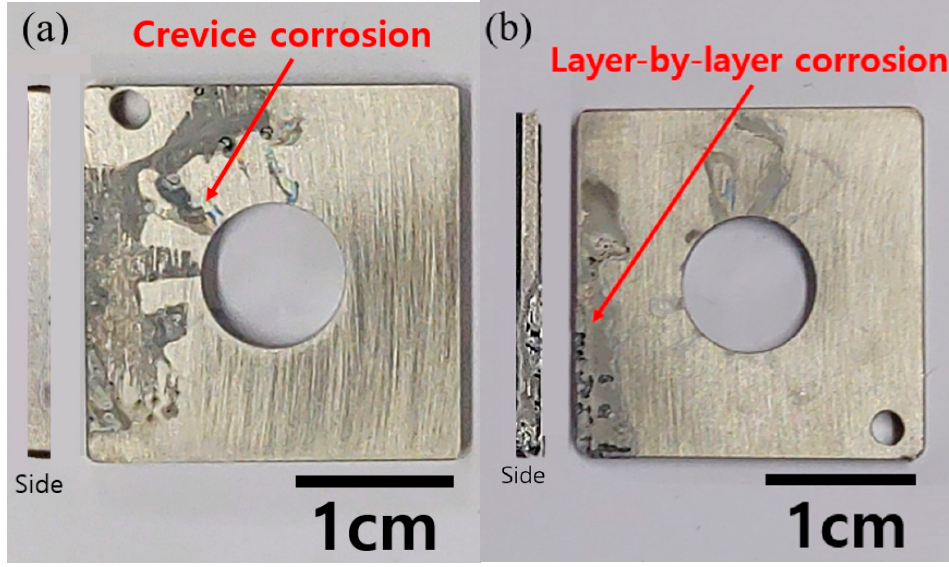
Figure 7. Different shapes of the corroded areas between ( a ) crevice corrosion of SM Ti ‐ 6Al ‐ 4V alloy and ( b ) layer ‐ by ‐ layer corrosion of AM Ti–6Al–4V